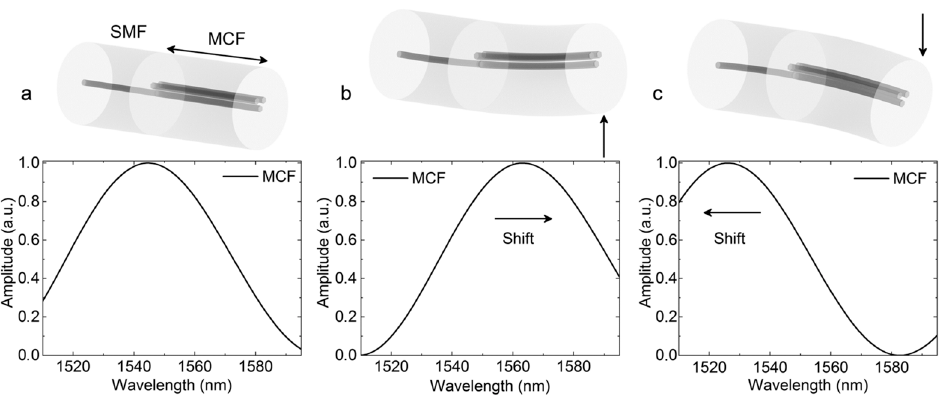
Figure 21. Simulated optical spectrum of the three-core-fiber-based supermode interferometer when the MCF is ( a ) straight, ( b ) bent upwards, and ( c ) bent downwards [20].